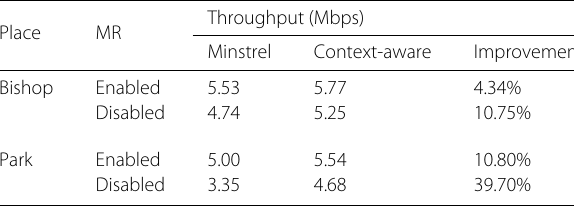
Table 9 In-field performance comparison